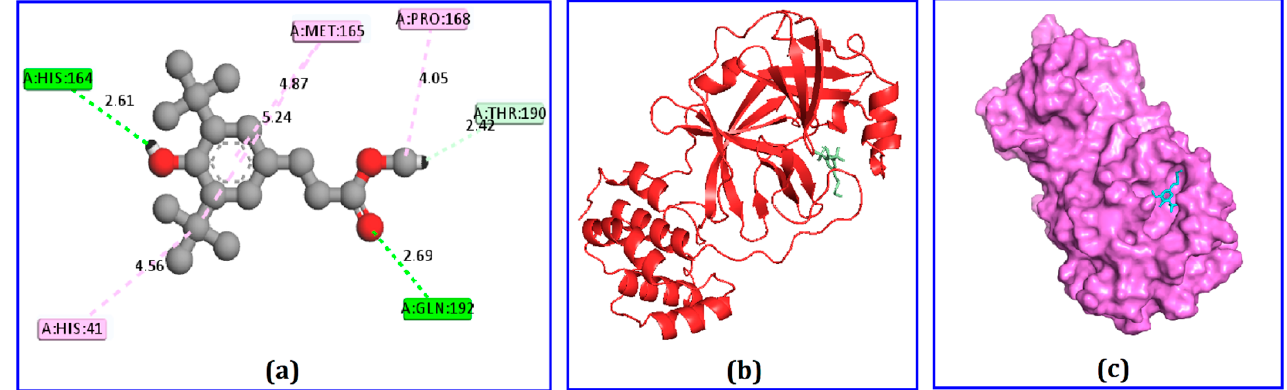
Figure 3. Binding interaction of the hydrocinnamic acid and main protease enzyme, ( a ) 2D representation of binding interaction, ( b ) 3D representation, and ( c ) surface view.